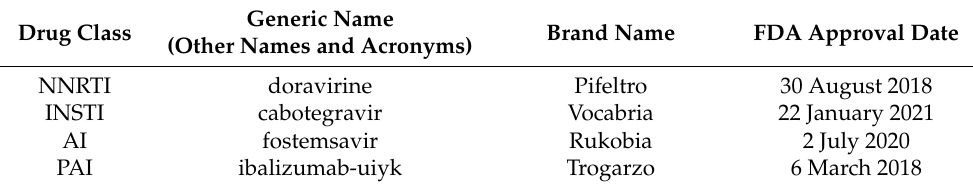
Table 4. FDA approved HIV medicines